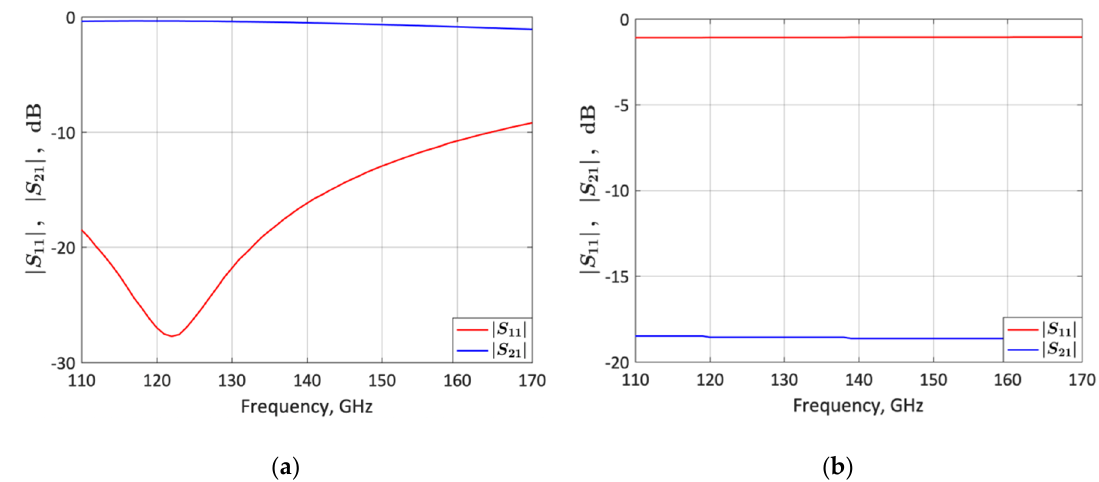
Figure 5. Simulated S -parameters of the HBT-RF switch of Figure 4a (designed on SG13G2 0.13 µm SiGe:C BiCMOS technology) taking into consideration the stubs L 10 and L 11 connected to the HBT base and emitter, respectively, as shown in Figure 1. ( a ) Switch in OFF state. ( b ) Switch in ON state.